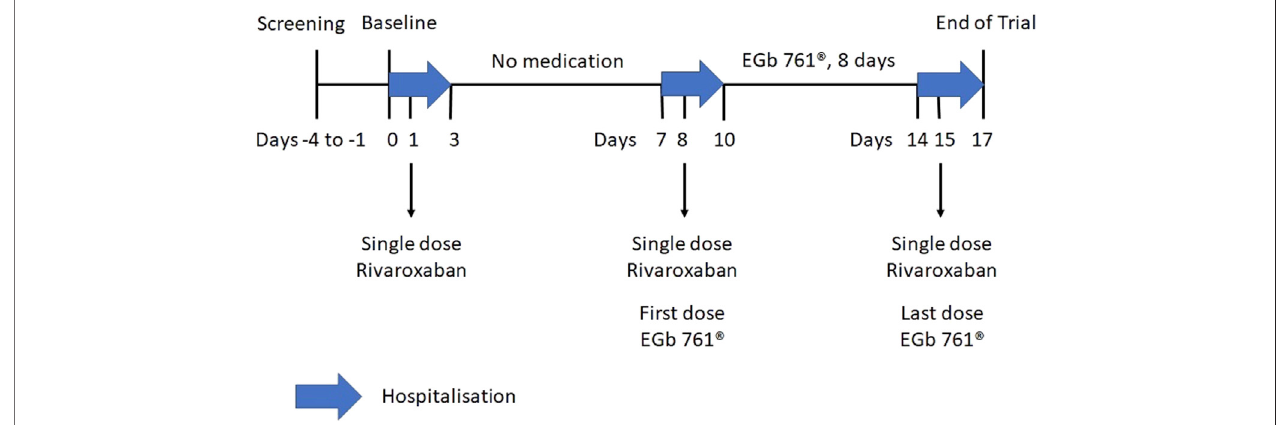
FIGURE 1 | Overview of the treatment periods in the drug-drug-interaction